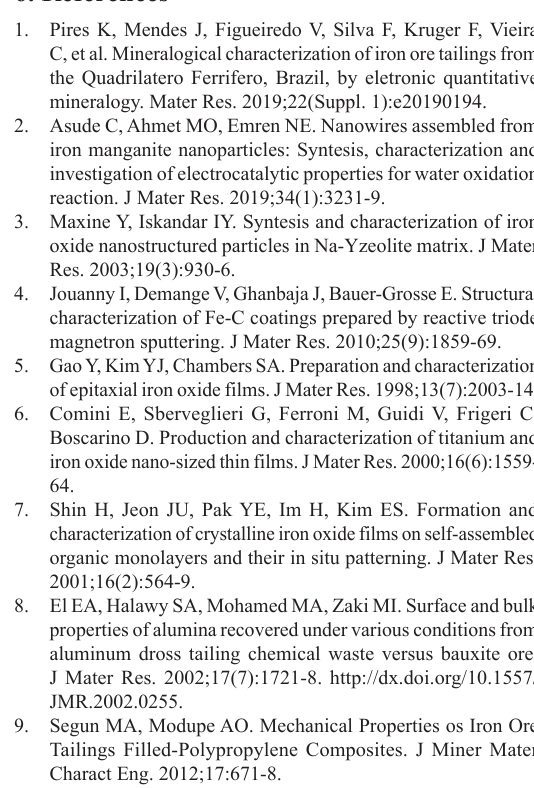
Figure 8. Mineral phase map of phosphate-ore tailings obtained from